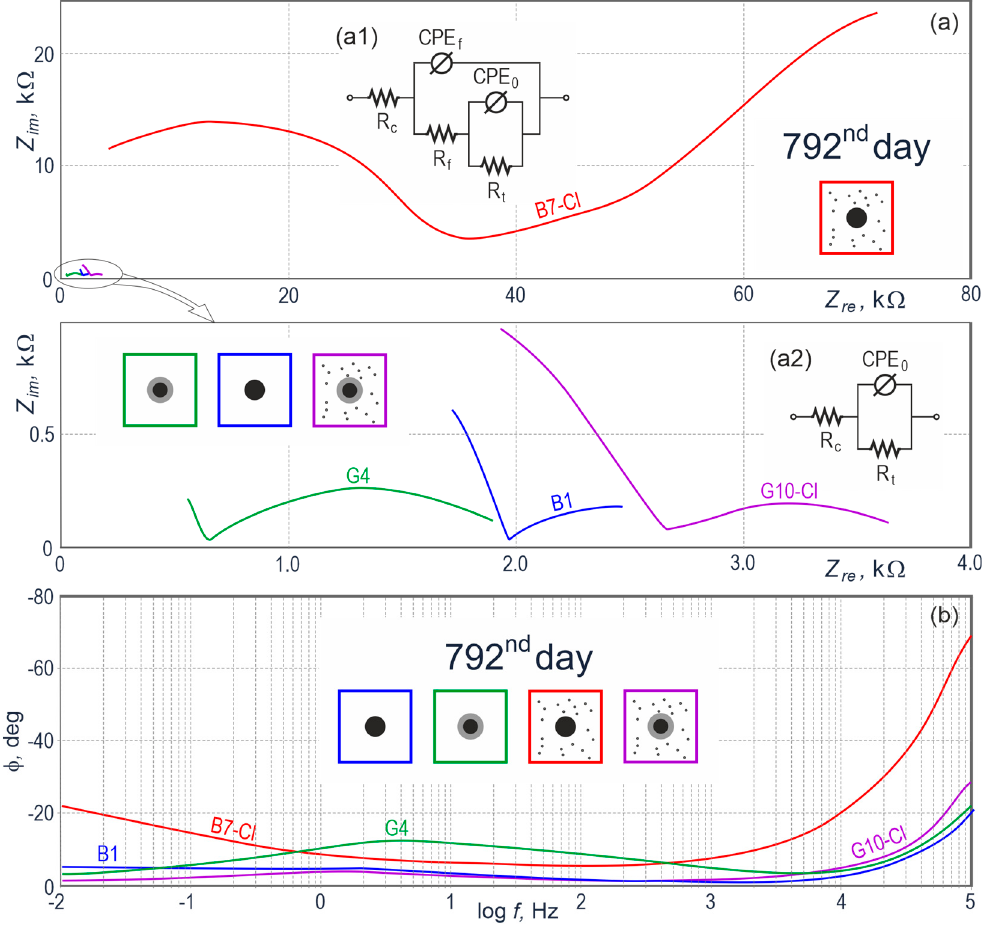
Figure 8. Results from impedance testing of steel reinforcement in concrete from 12 specimens on day 792 of measurements illustrated at the Nyquist ( a ) and Bode ( b ) plots, directly prior to microscopic tests B1 —black steel in concrete without additives, G4 —galvanized steel in concrete without additives, B7-Cl —black steel in concrete with chlorides, and G10-Cl —galvanized steel in concrete with chlorides; ( a1 ) electrical equivalent circuit for the B-Cl spectra group, ( a2 ) electrical equivalent circuit for the B, G and G-Cl spectrum groups